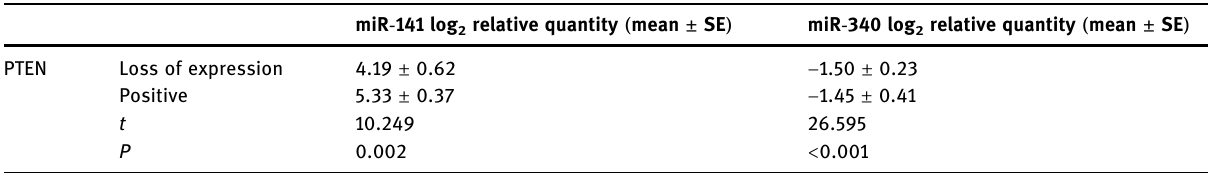
Table 8: Relationship between PTEN and miR - 141/miR - 340 levels in CSCC miR - 141 log 2 relative quantity ( mean ± SE